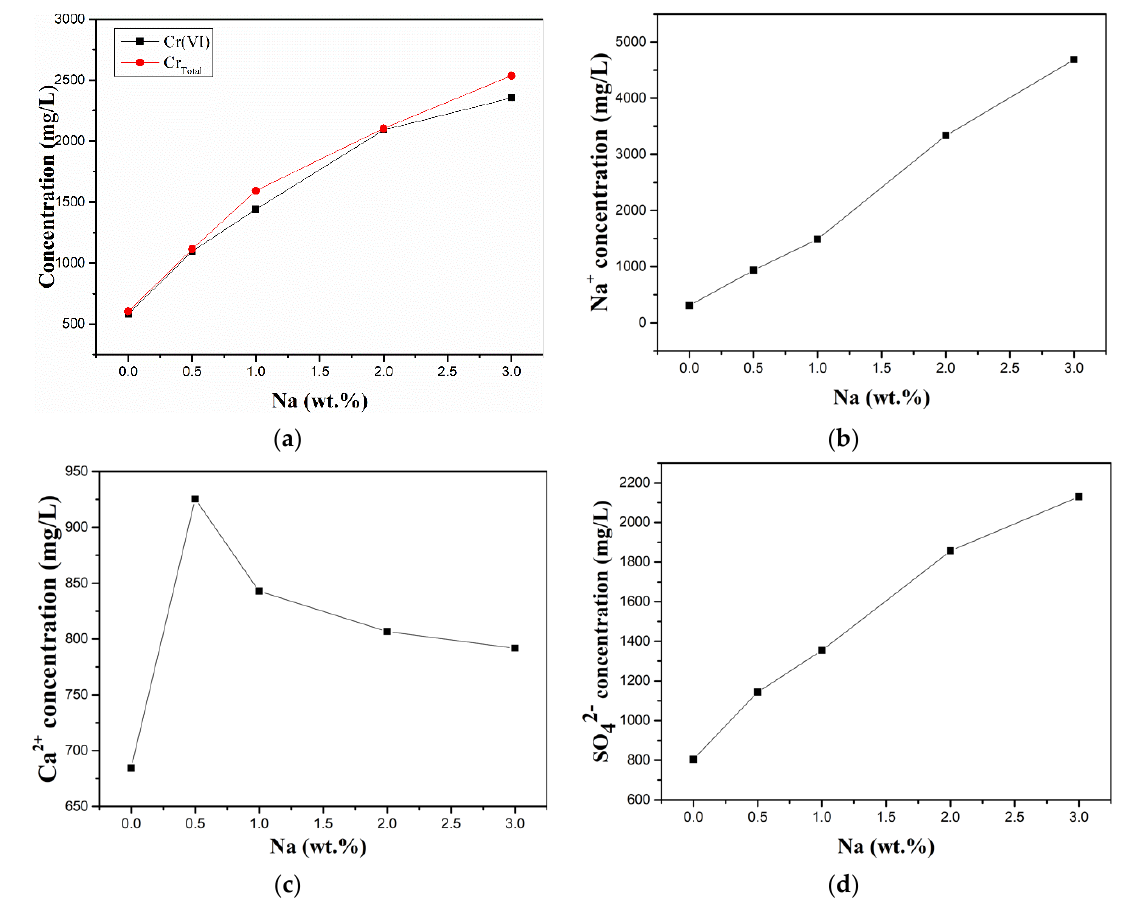
Figure 5. Concentrations of ( a ) Cr Total and Cr(VI), ( b ) Na + , ( c ) Ca 2+ , and ( d ) SO 42 − in the filtrates of B1–B5.